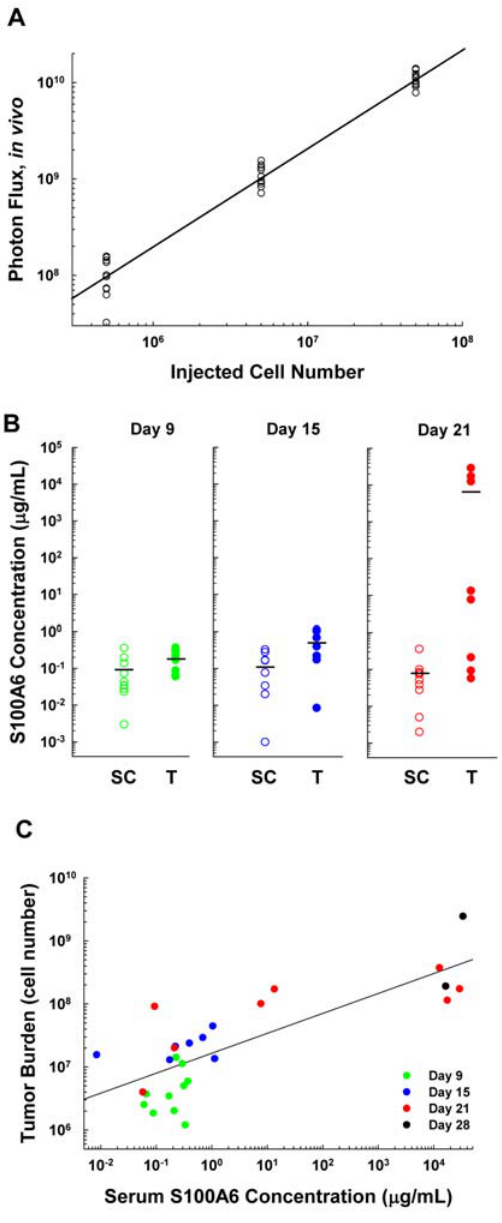
Figure 6. Detection of S100A6 in serum over time from mice with OVCA, in association with estimated peritoneal cavity tumor burden. (A) Photon flux measurements obtained from mice harboring defined numbers of bioluminescent SKOV-3-Luc cells within the peritoneal cavity. Regression analysis was performed on (log 10 ) photon output vs. (log 10 ) numbers of inoculated cells to produce a standard calibration curve using an inverse prediction equation (see Materials and Methods). This was used to predict tumor burden from photon flux measurements (see also figure 6C). (B) Comparisons of serum S100A6 in tumor-bearing (T, closed circles) and saline-inoculated control mice (SC, open circles). Serum S100A6 concentrations, tested as individual specimens from multiple mice by ECLISA (plotted as individual values with horizontal line at median value), were significantly different between T vs. SC at each of three times tested post inoculation, 9 days (p=0.015), 15 days (p=0.036), and 21 days (p=0.0031) (Wilcoxon Rank Sum test). (C) Correlation between estimate of tumor burden in OVCA carcinomatosis and concentration of serum S100A6, as measured by ECLISA from tumor-bearing mice (r=0.79, p , 0.0001).